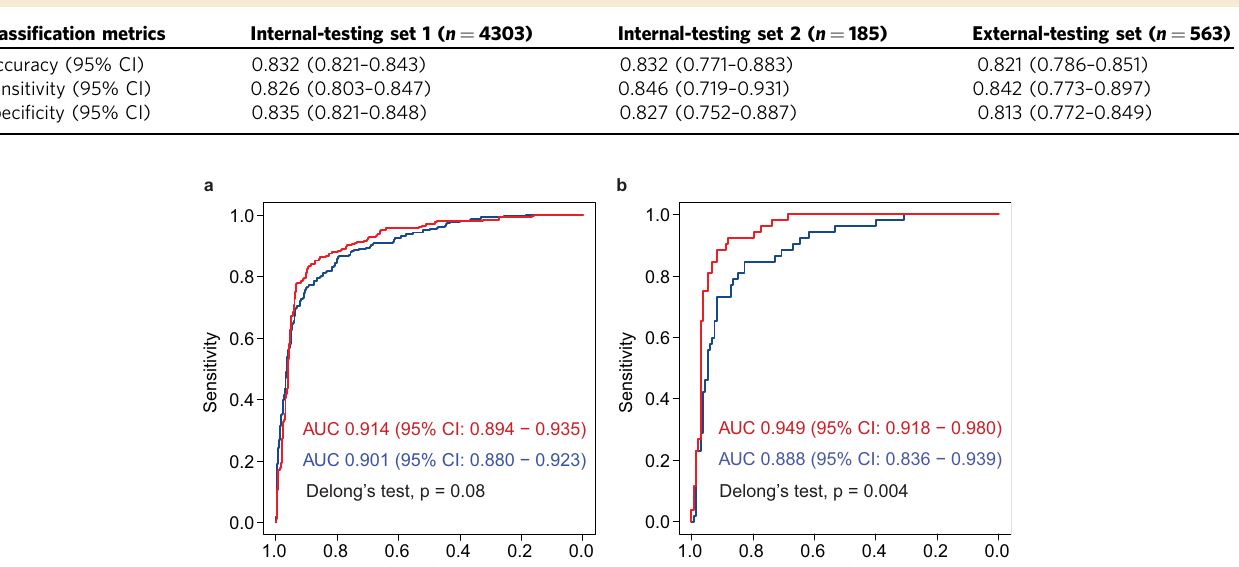
Fig. 3 The ROC curves of HTNet with and without integration of serologic markers on static-image and video stream testing sets. a The fi rst internal- testing set of static images, ( b ) the second internal-testing set of video stream. Red and blue ROC curves indicate HTNet with and without integration of serologic markers, respectively. Two-sided Delong ’ s test is used to test the difference between two ROC curves. Area under the operating curve and associated 95% con fi dence intervals are